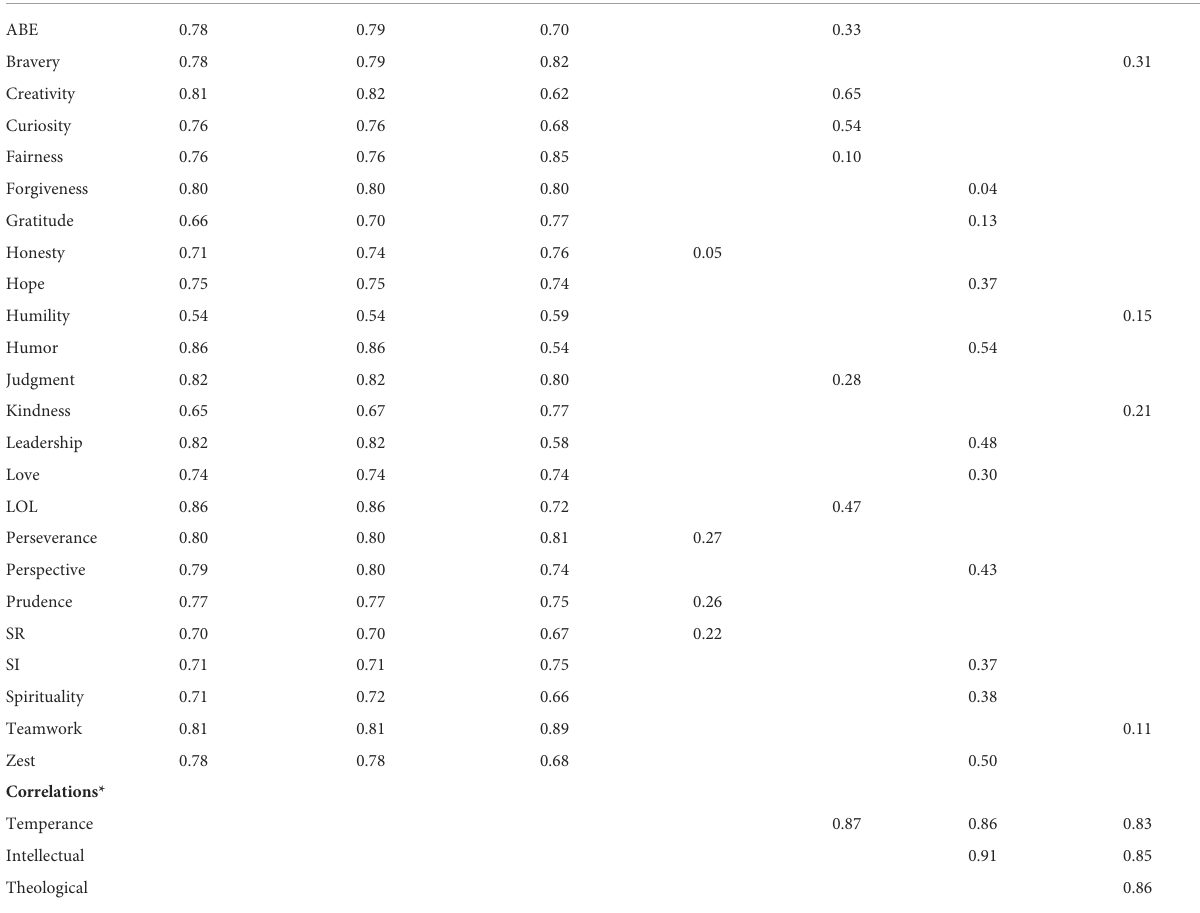
TABLE 1 The internal consistency and factor loadings of the Chinese version VIA